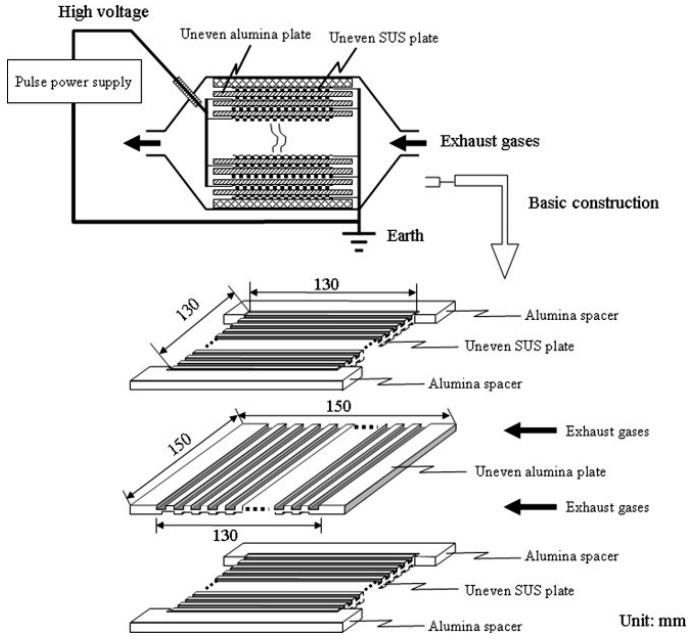
Figure 10. The construction of the uneven DBD reactor. Reprinted from Reference [91], with permission from John Wiley and Sons.